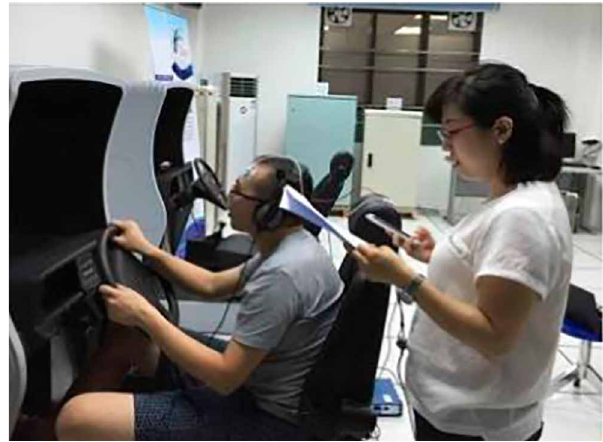
Figure 3: Driving simulator